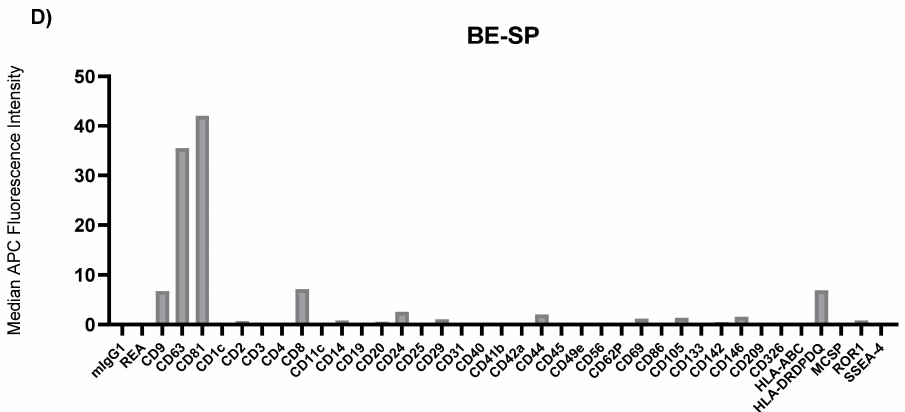
Figure 3. Median fluorescence intensity EV surface protein profiles of benign (BE) pleural effusion differential centrifugation fractions: apoptotic bodies (AB) ( A ), microvesicles (MV) ( B ), exosomes (EX) ( C ) and soluble protein in supernatant (SP) ( D ). mIgG1 and REA indicate isotype control and represent negative markers. Each bar corresponds to one surface epitope measurement, as indicated on the x -axis.